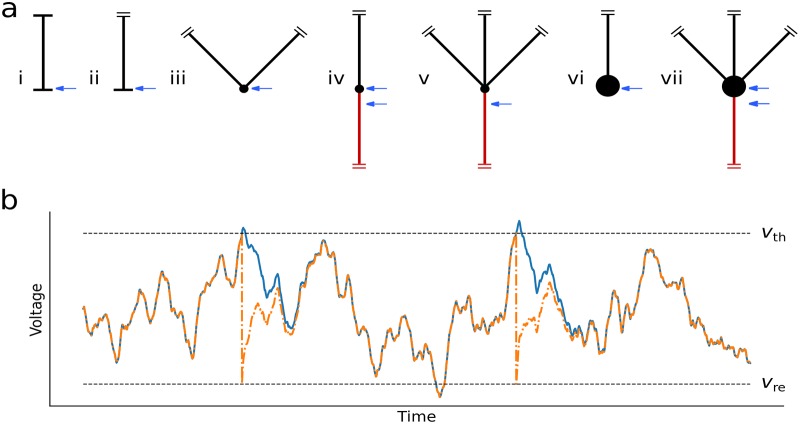
(a) The morphologies examined in this paper: (i) closed dendrite, (ii) semi-infinite one-dendrite model, (iii) two-dendrite model, (iv) dendrite and axon, (v) multiple dendrites and axon, (vi) dendrite and soma, (vii) multiple dendrites, soma and axon. Long black lines denote dendrites, red lines indicate the axon, while the blue arrows indicate the different spike trigger positions used. The other marks in the diagrams illustrate the following features: horizontal line—sealed end, two parallel lines—semi-infinite cable, small circle—nominal soma, and large circle—electrically significant soma. (b) Illustration of the upcrossing approximation. If the time between firing events is long compared to the relaxation time, the voltage without reset (solid blue line) will converge to the voltage of a threshold-reset process (orange dashed line) for the same realization of stochastic drive. Under these conditions the upcrossing and firing-rates for the two processes are comparable.